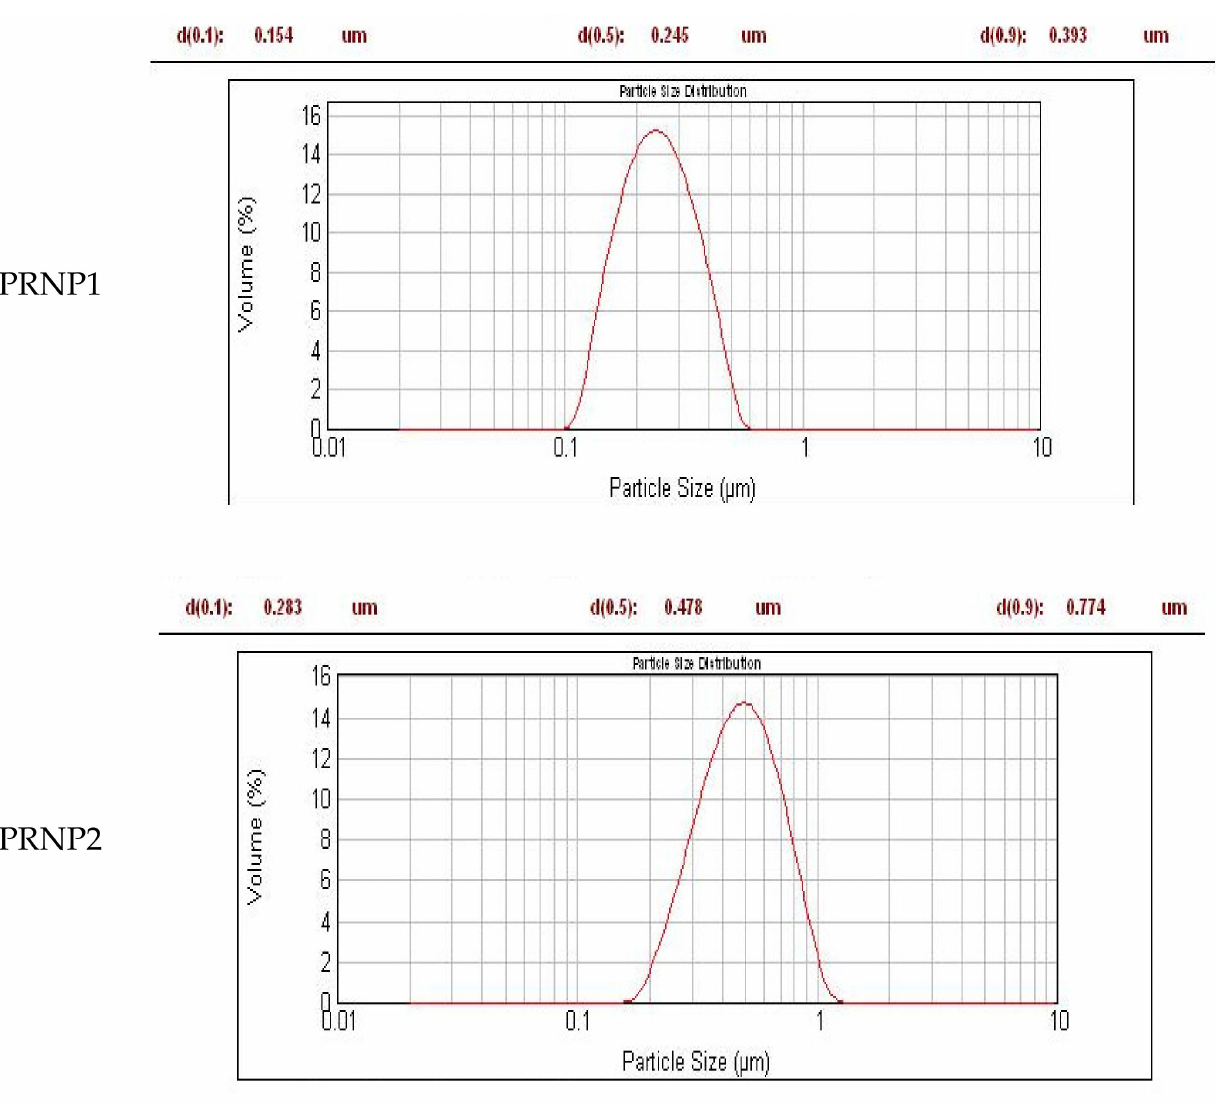
Figure 2. Particle size by laser diffraction technique of prepared polymer nanoparticles of doxycycline prepared by nanoprecipitation technique (displaced for better